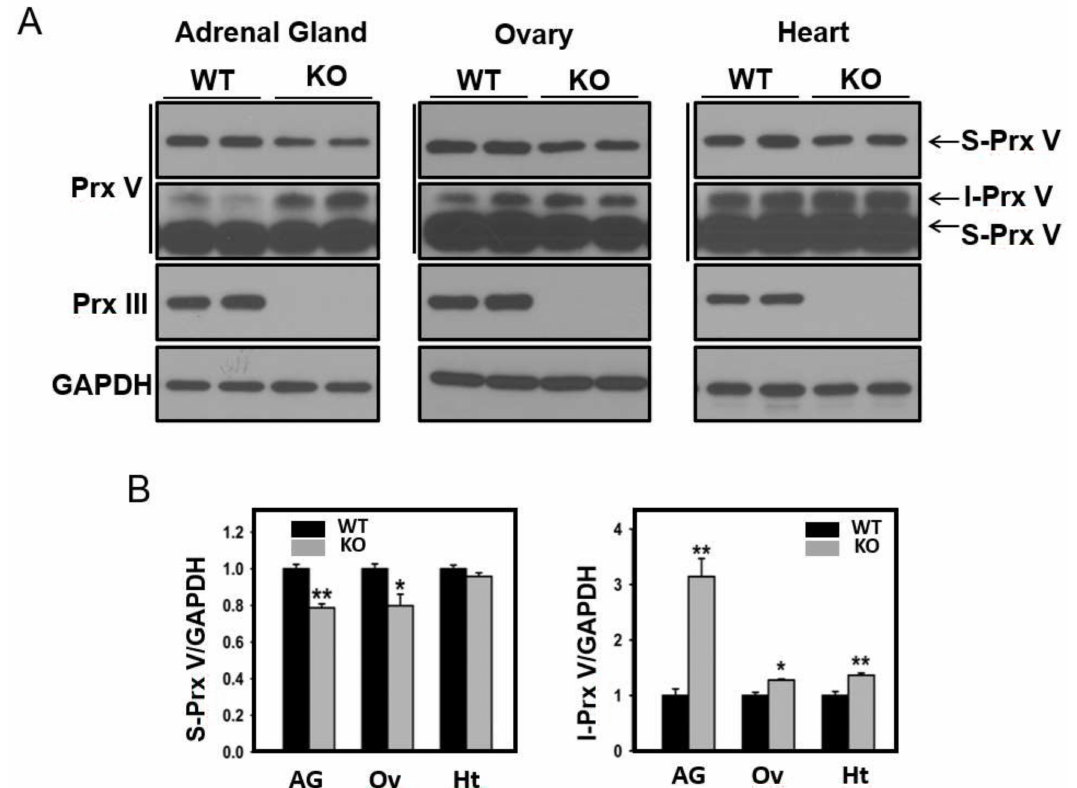
Figure 4. Effect of Prx III deletion on L-Prx V maturation. ( A ) Whole tissue lysates of adrenal gland, ovary, and hearts were obtained from wild type and Prx III KO mice were subjected to immunoblot analysis with antibodies to Prx V, Prx III, and GAPDH. Two different blot exposures are shown for Prx V blot. ( B ) The band intensities of S-Prx V and I-Prx V are normalized to the intensity of GAPDH. Data are means ± SE ( n = 3 per group), * p < 0.05, ** p <